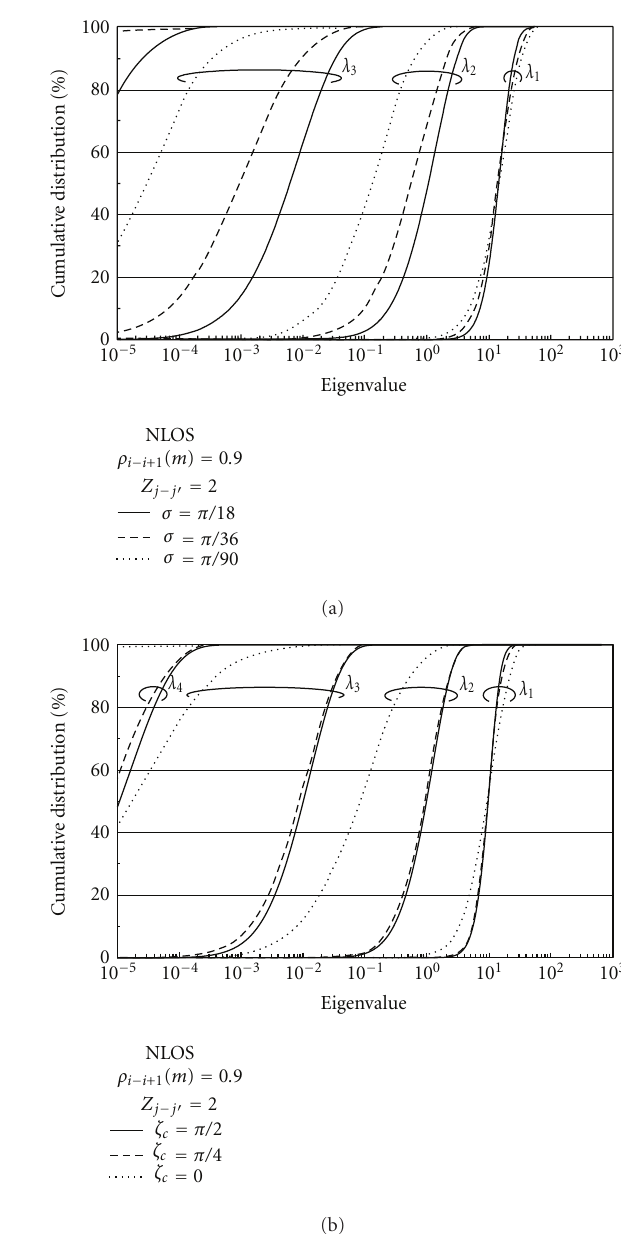
Figure 9: Dependence of eigenvalue on Gaussian distribution (4 × 4 MIMO). (a) E ff ect of standard deviation. (b) E ff ect of centering arriving